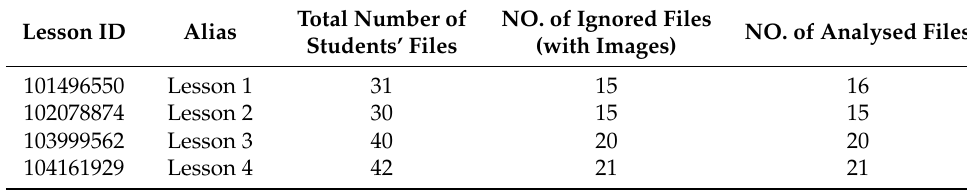
Table 1. The synthesis of resources: Number of students’ files in each